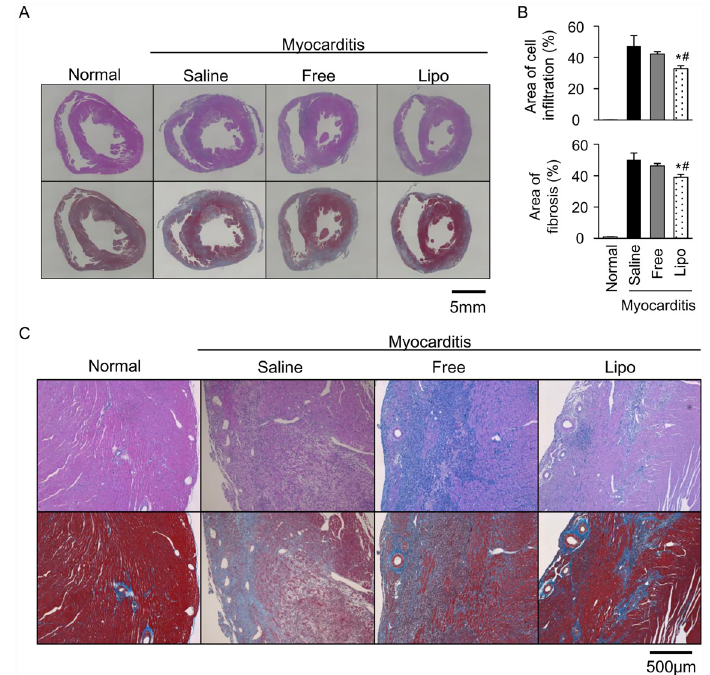
Fig 5. Effects of free and liposomal FK506 on histological findings in the myocarditic hearts. Representative transverse sections in ventricles stained with hematoxylin and eosin (upper panels) and Masson ’ s trichrome (lower panels) at low magnification (A) and high magnification (C). (B) Quantitative analysis of areas of cell infiltration and fibrosis (N = 4 – 12 in each group). Scale bars indicate 5mm and 500 μ m in (A) and (C), respectively. Data are expressed as the mean ± SEM. * P < 0.05 versus the saline treated group. # P < 0.05 versus the free FK506 treated